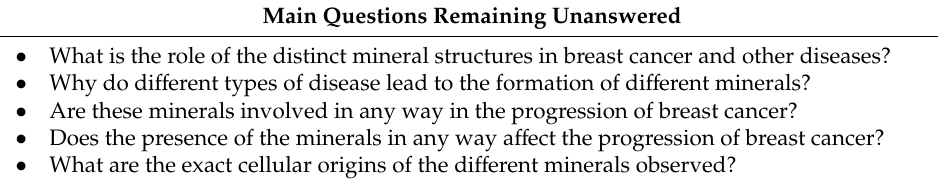
Table 3. List of main questions that remain unanswered in relation to breast calcification. Main Questions Remaining